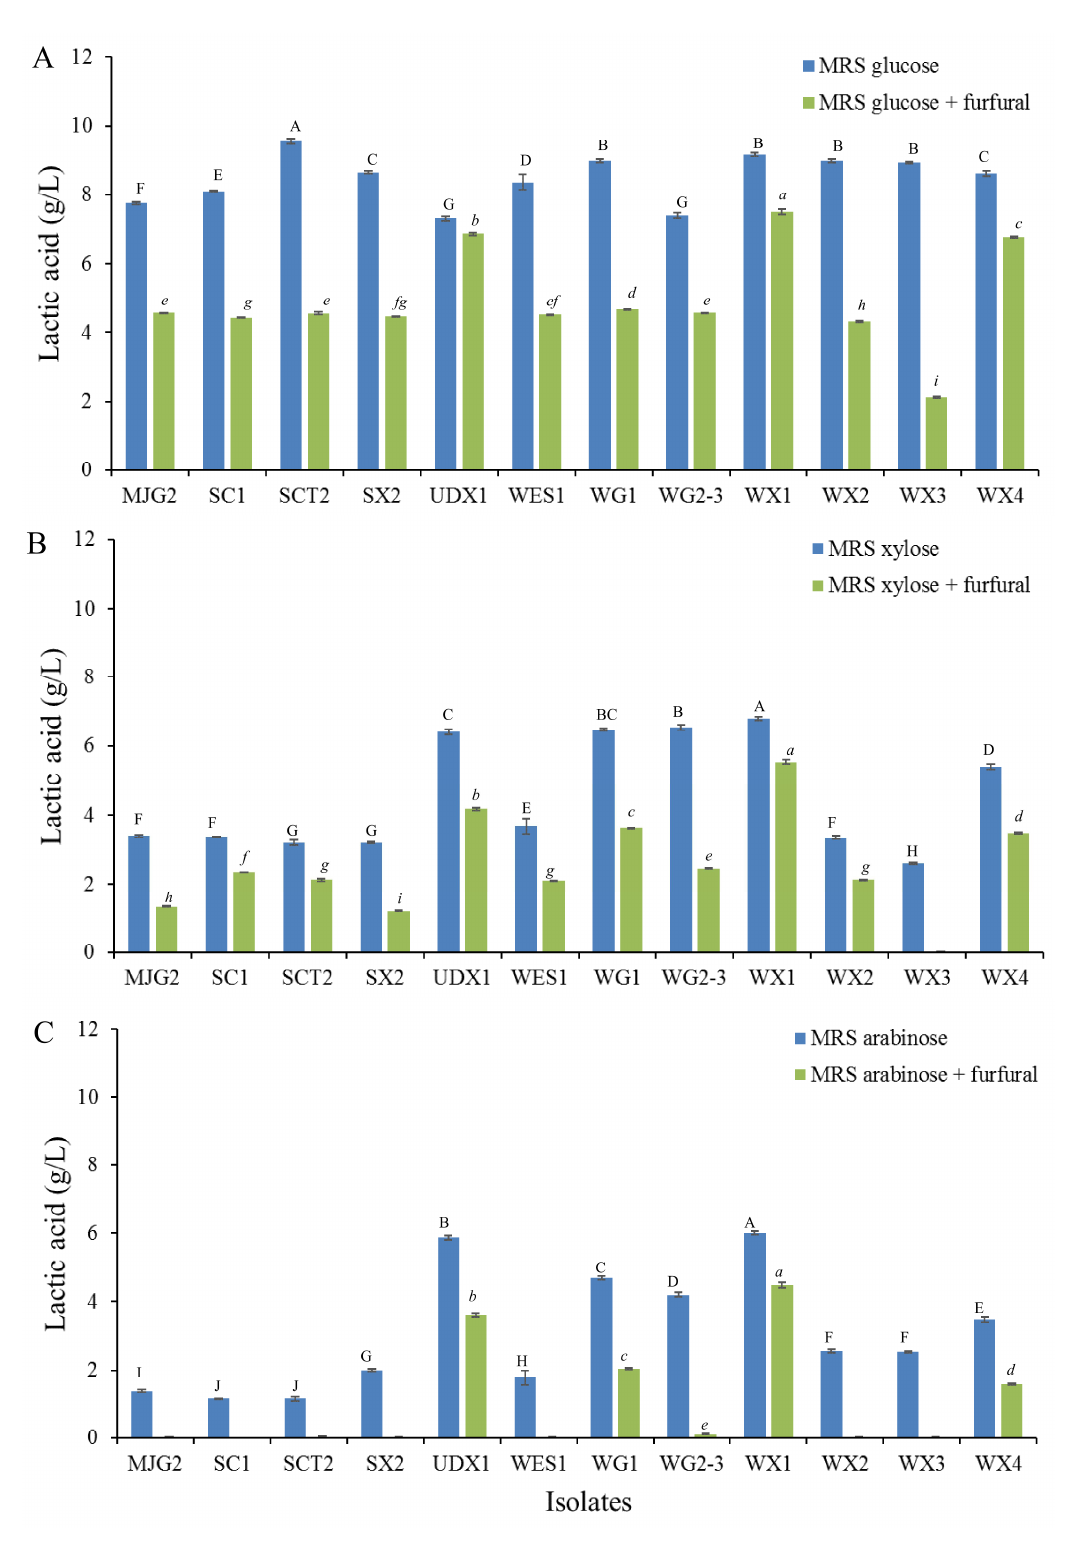
Figure 2. Lactic acid production of twelve selected bacterial isolates cultivated in MRS broth with 10 g/L glucose ( A ), xylose ( B ) and arabinose ( C ) supplemented with 2 g/L furfural at 37 °C for 48 h. Different capital letters (A–J) and small letters (a–i) indicate significant differences between the test groups of each media ( p < 0.05).